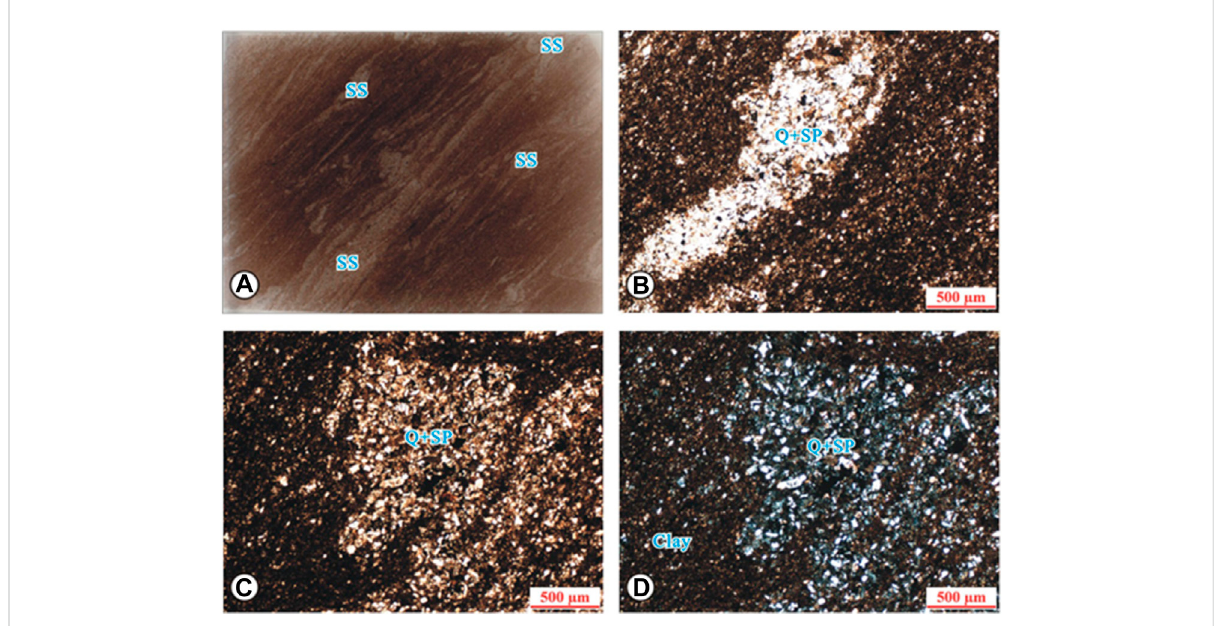
FIGURE 3 Thin section photo of grayish black silty banded dolomitic mudstone rock (A) , Lime mudstone; (B) , Dolomitic mudstone; (C) , Silty mudstone; (D) , mudstone rock.